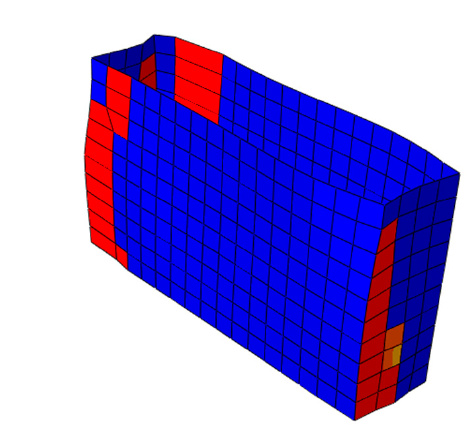
( b ) Figure 7. ( a ) Constitutive model of elastoplastic damage for concrete under compression. ( b ) Con- stitutive model of elastoplastic damage for concrete under tension. It can be seen from Figure 8 that the failure mode of FWPs in the numerical model was the same as that in the component tests. The CFRP was torn down at the corners of the FWPs. The position marked in red in the Figure 8b indicates that the stiffness of the CFRP has degraded to 0, showing that the CFRP is torn down at the corner. It can be